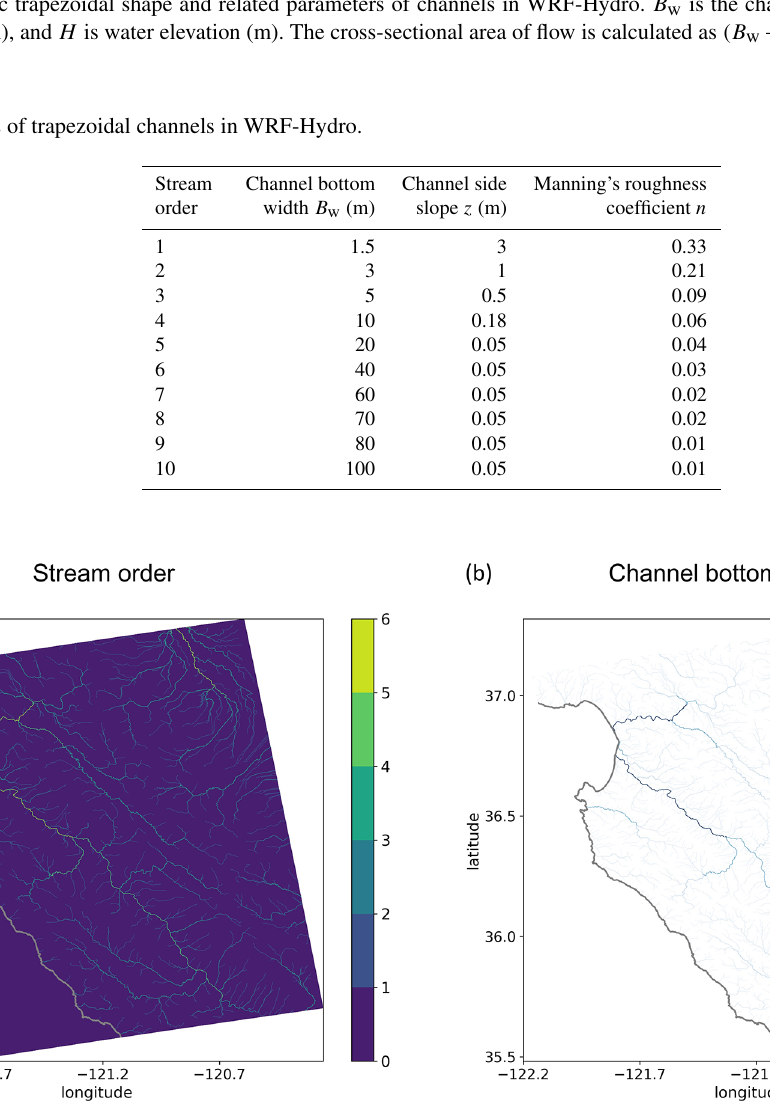
Figure B3. (a) Stream order defined by the USGS 30m DEM in our WRF-Hydro model domain and (b) the channel bottom width B w (m), which is a function of stream order (Table